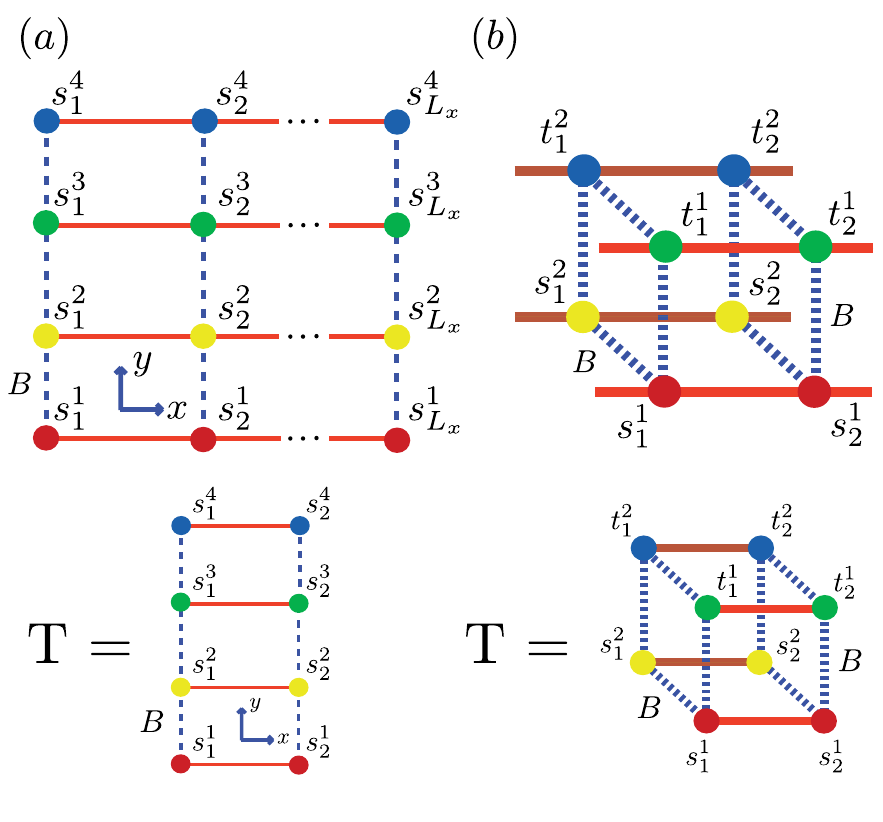
Figure 6. ( a ) Lattice representation and transfer matrix of α -synuclein fibrils composed of 4 filaments; ( b ) The fibril for Aβ is composed of two protofibrils, each represented by a strip lattice and spin-variables s and t . The strips are stacked in-register along the z -axis, and the parameter B (dashed, green) lines represents the bonds between sheet proteins in protofibrils or